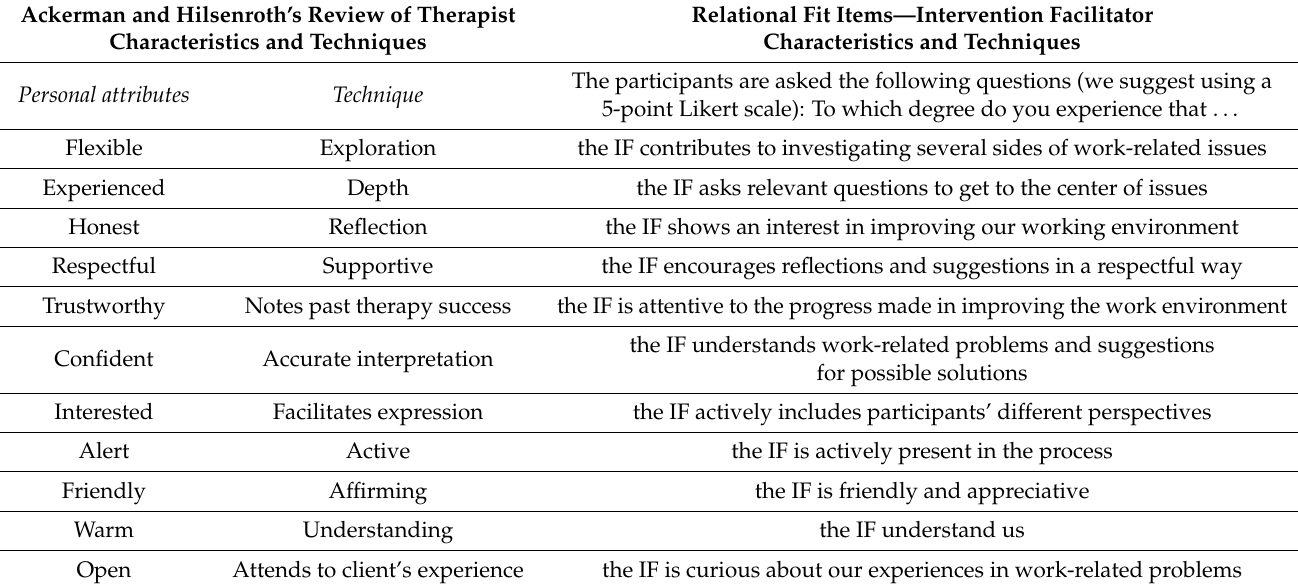
Table 1. (Re)conceptualization of therapist characteristics and techniques into the relational fit: IF characteristics. Ackerman and Hilsenroth’s Review of Therapist Characteristics and Techniques